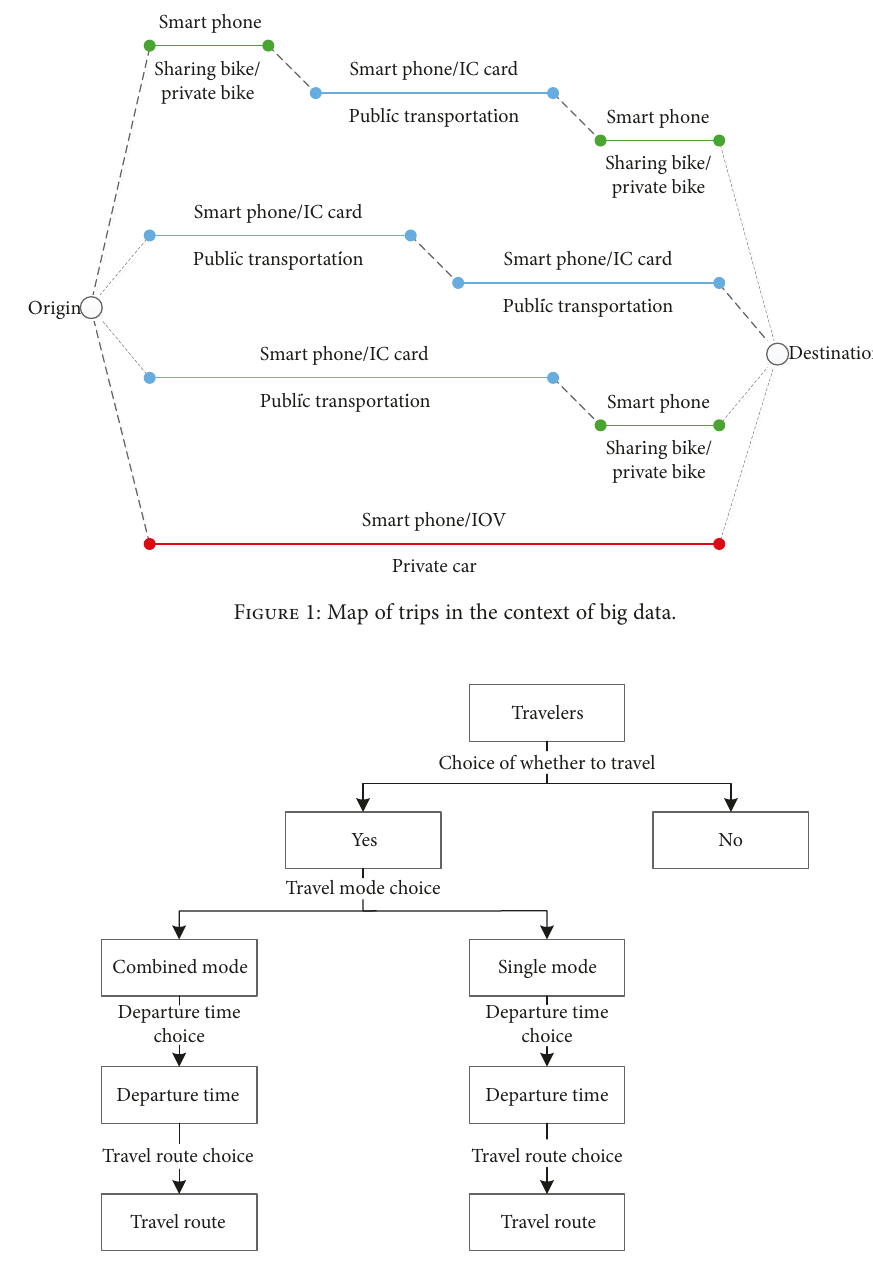
Figure 2: Sustainable routing choice considering guidance e ff